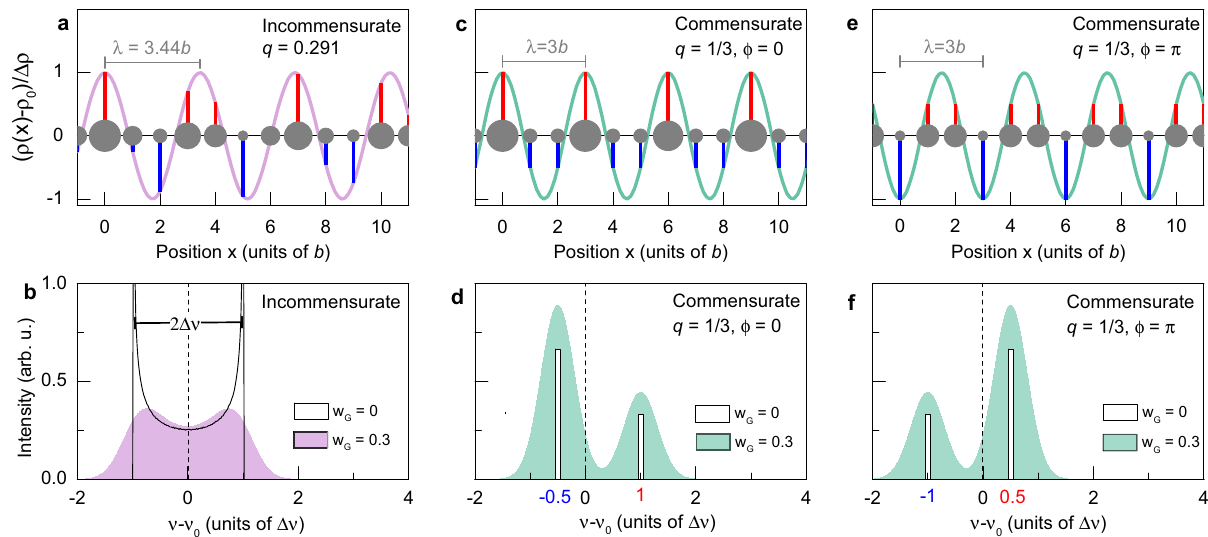
Fig. 1 NMR line shapes for incommensurate and commensurate unidirectional CDWs. a Incommensurate sinusoidal charge modulation ρ ð x Þ ¼ ρ þ Δ ρ cos ð q (cid:2) x þ ϕ Þ with period λ = 2 π / ∣ q ∣ = 3.436 b . Grey dots of different sizes depict atoms with varying charge density. Red and blue bars mark the 0 sampled positive and negative CDW amplitude at the atomic positions (separated by the lattice constant b ). b Black line: characteristic histogram for an incommensurate CDW, determined by sampling the modulation shown in ( a ) at the atomic positions: there are two singularities (equally shifted from the 0 position that corresponds to the resonance position ν 0 in the absence of a CDW) and a continuum of intensity in between the singularities since the incommensurate nature implies that the charge modulation is sampled by nuclei at an in fi nite number of different values in between the two extrema, regardless of the values of both the period and the phase. Any incommensurate wave vector, whatever its value, leads to the exact same NMR line shape. For this fi gure, we thus use q = 0.291, a value slightly smaller than the experimental value q = 0.323 for p = 0.11, because this makes it easier to visualise